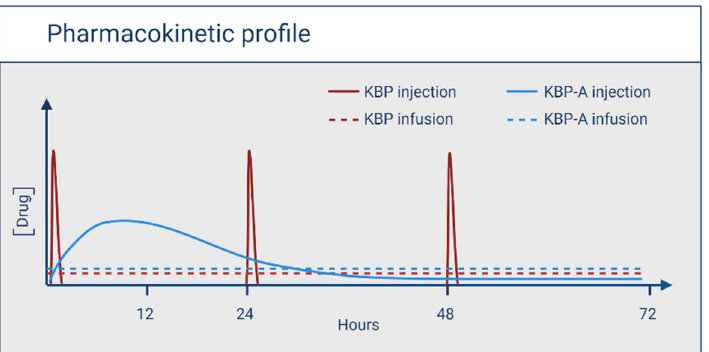
Figure 1. Schematic illustration of the pharmacokinetic profiles of KBP and KBP-A dosed by injec- tion or infusion. Created with Biorender.com. or infusion. Created with